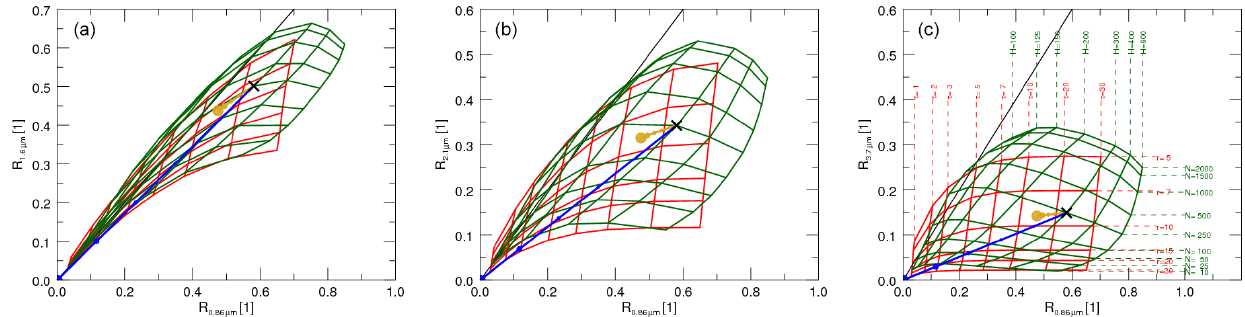
Figure 1. Nakajima–King plots showing idealized relations between satellite-observed reflectances and retrieved cloud variables over a black surface for all three MODIS bands used for retrievals. The x -axis shows the reflectances at 0.86µm, the y -axis the reflectance at 1.6, 2.1, and 3.7µm, respectively. The red mesh shows the dependency of retrieved optical depth (“ τ ”, dimensionless, given in panel c ) and retrieved effective radius (“ r ”, in µm) on reflectance. The green mesh shows the dependency of retrieved CDNC (“ N ”, in cm − 3 ) and cloud geometrical thickness (“ H ”, in metres) on the reflectance. The thin black line is the one-to-one line for reference. The thick blue and golden lines indicate the impact of partly cloudy scenes (blue) and absorbing aerosol above the clouds (golden). More details are provided in the text.